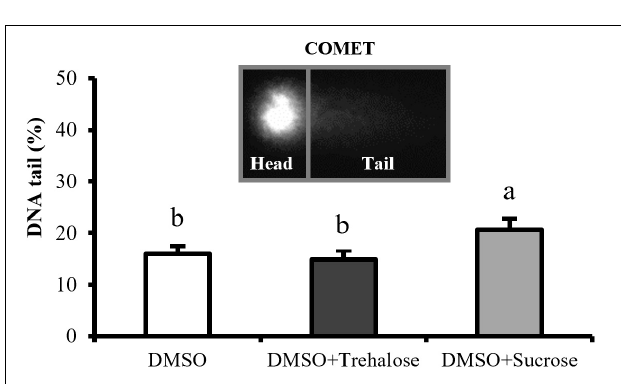
FIGURE 2 | Motility of C. angulata sperm frozen with 10% dimethyl sulfoxide (DMSO) (white bar) and 10% DMSO supplemented with 0.45 M trehalose (black bar) or sucrose (gray bar). Results were expressed in mean percentages ± SD ( n = 10). No significant differences between cryoprotectant solutions [one-way ANOVA followed by Student–Newman–Keuls (SNK) as post hoc test; p < 0.05].